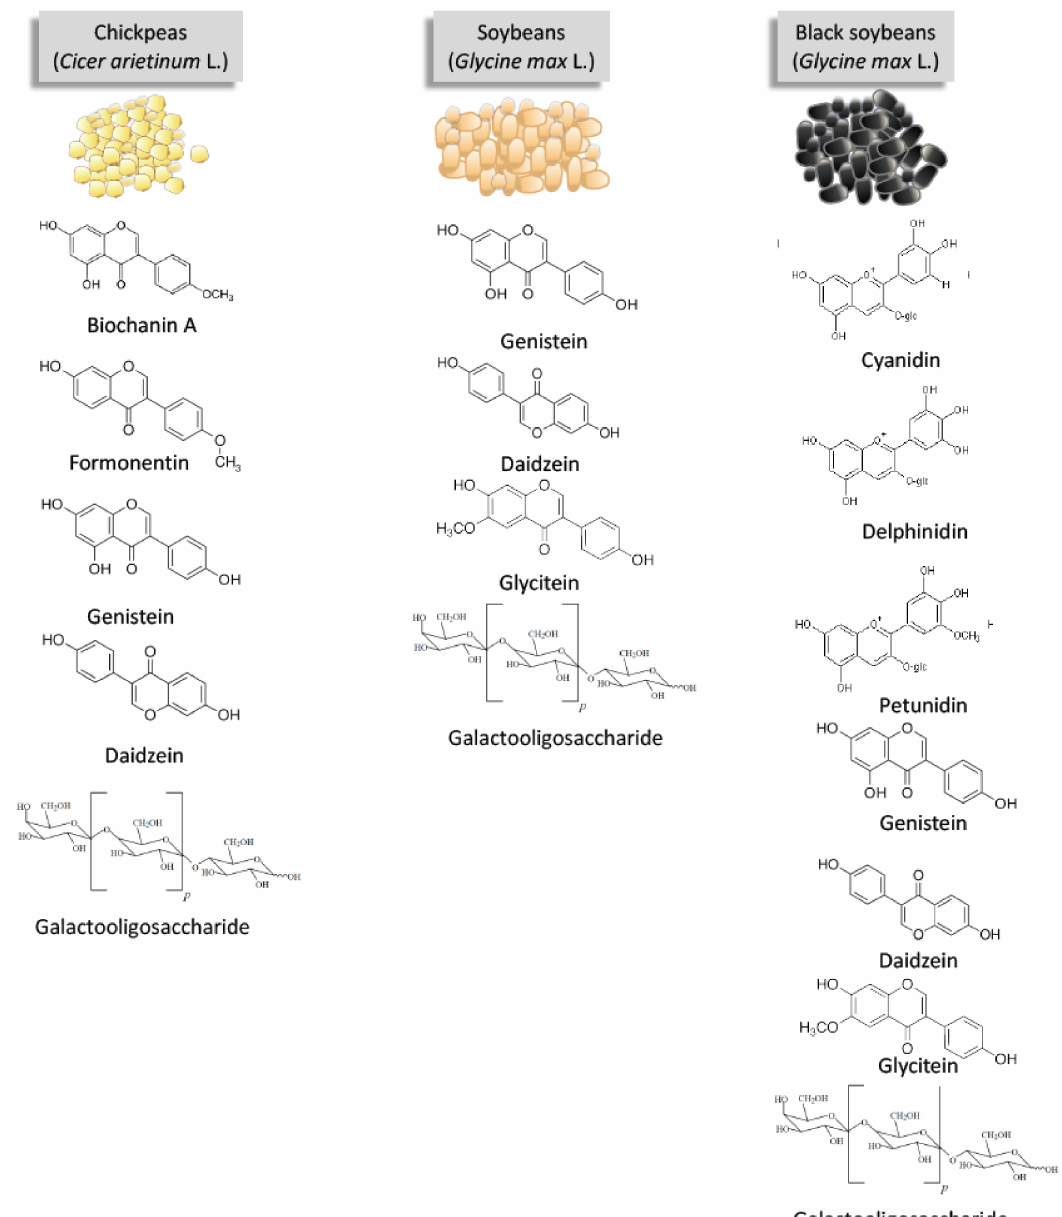
Figure 1. The bioactive compounds present in soybeans and chickpeas as discussed in this